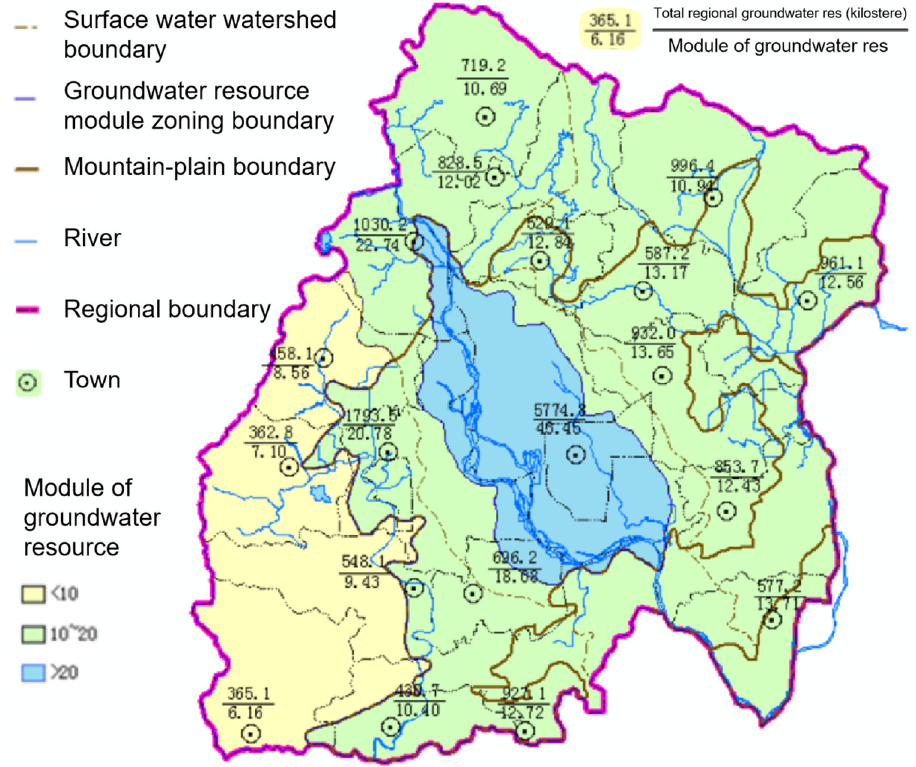
Figure 1. Sketch of the Qian’an reach of the Luanhe River.